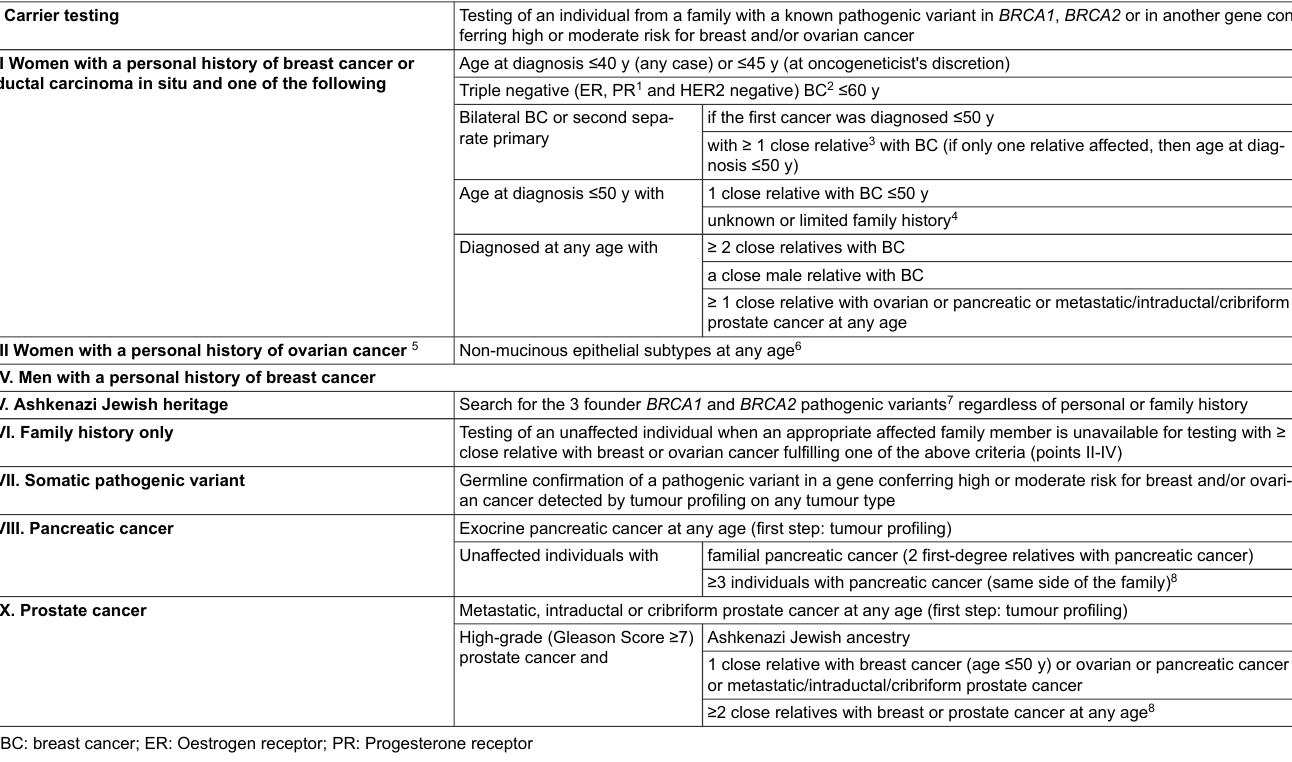
Table 1: Swiss guideline for referral, risk assessment, genetic counselling and testing of individuals with a suggested cancer predisposition syndrome. I Carrier